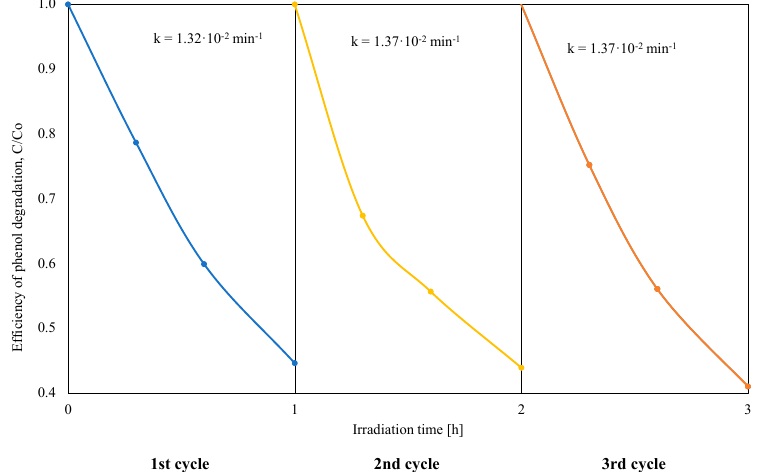
Figure 9. Efficiency of UV-Vis phenol degradation in the presence of defective d-TiO 2 _20/Pt0.1/Cu0.1 photocatalyst measured in the three subsequent cycles. There was no significant change in phenol degradation rate constant after the second and third cycles. Thus, the analyzed photocatalyst revealed good stability and reusability.